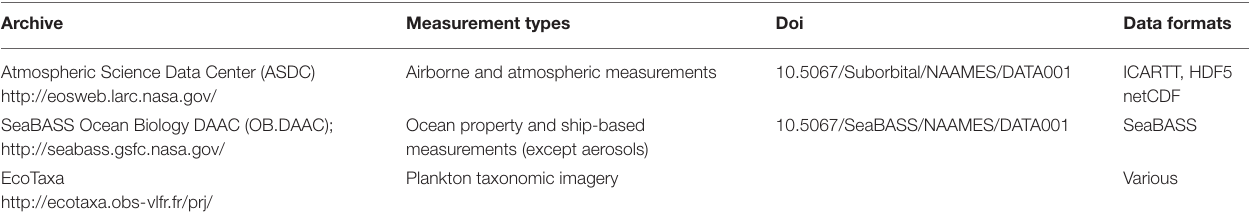
TABLE 3 | Summary of NAAMES data